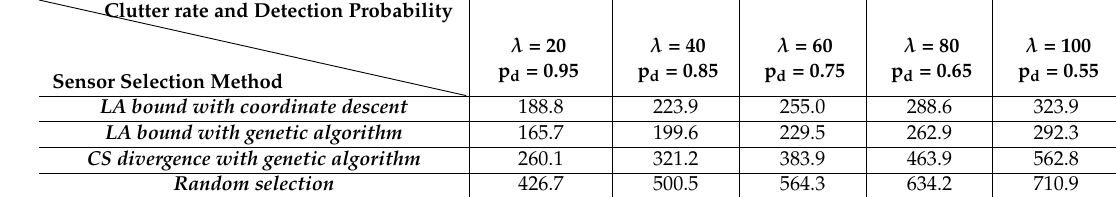
Table 2. Final value of LA error (Unit: